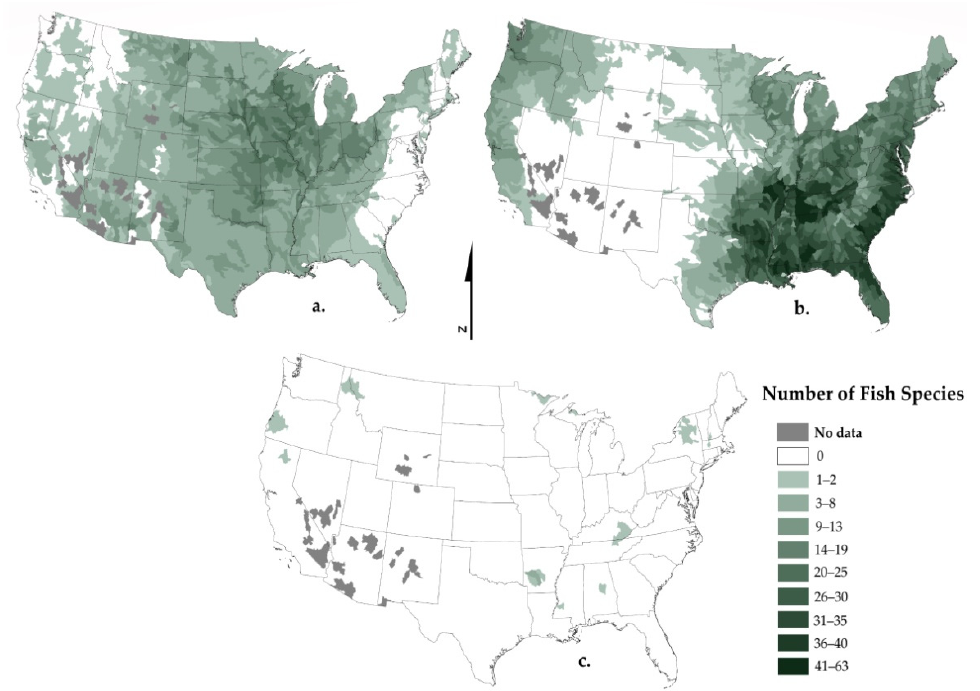
Figure 4. ( a ) Fish species richness associated with low-forested areas (HUC8s for whom more than one quarter of their distribution is associated with 26–50% forested area). ( b ) Fish species richness associated with forested areas (HUC8s for whom more than half of their distribution occurs in HUCs with 51–75% forested area). ( c ). Fish species richness associated with highly forested areas (HUC8s that have more than three quarters of their distribution in HUC8s with 76–100% forested area).